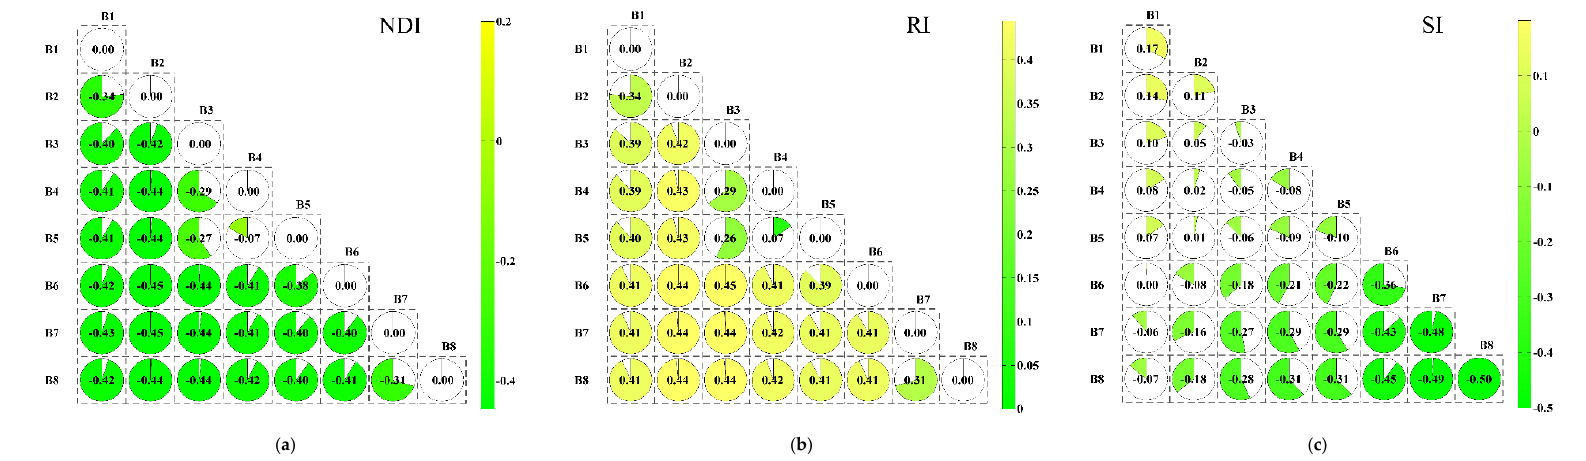
Figure 5. The correlation analysis between EC and optimized spectral indices based on original data (R). ( a ), ( b ), ( c ) represent the correlation EC with NDI, RI, and SI, respectively.